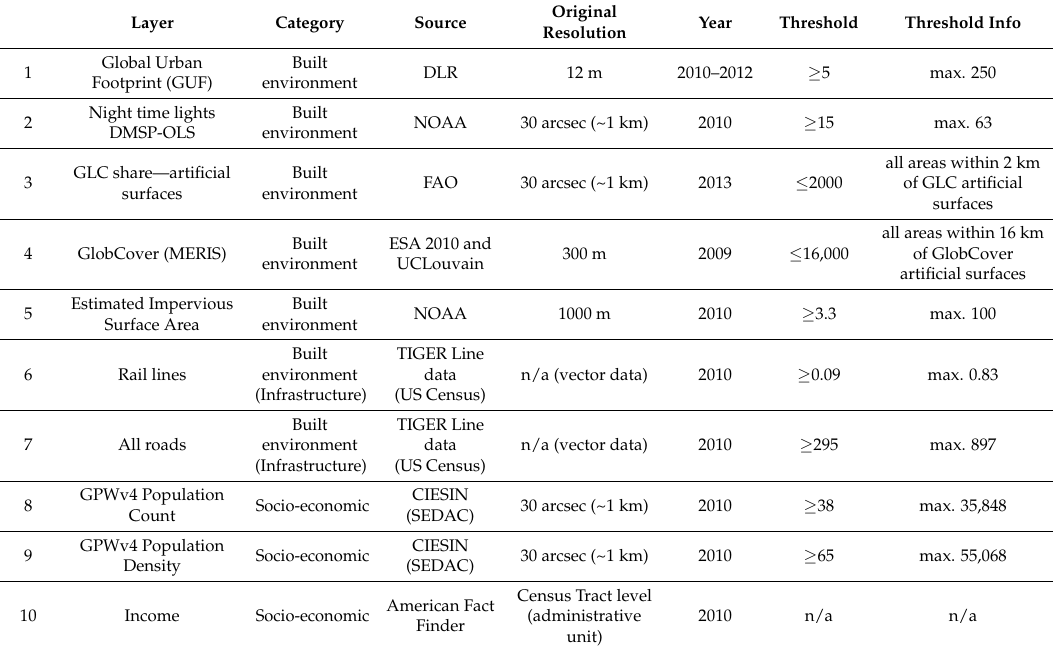
Table 4. Input layers: Built environment ( 1 – 5 ), infrastructure ( 6 , 7 ), socio-economic data ( 8 , 9 ) and one socio-economic data layer for plausibility ( 10